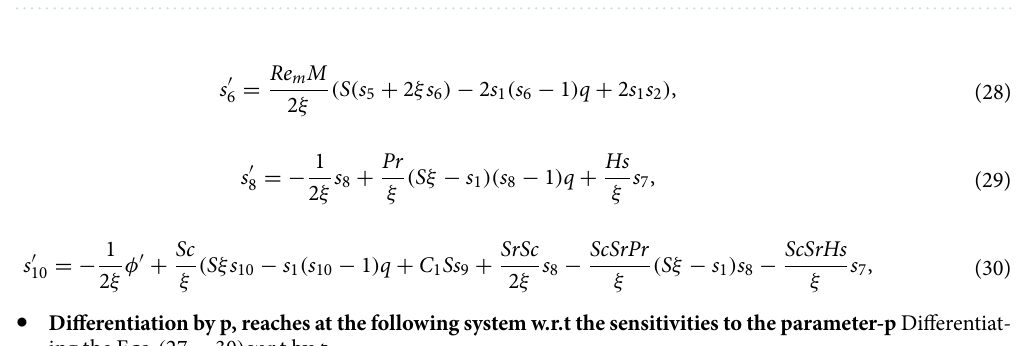
Table 1. Comparison of the numerical results by two methods PCM and BVP4C for Skin friction and Nusselt number, with various physical